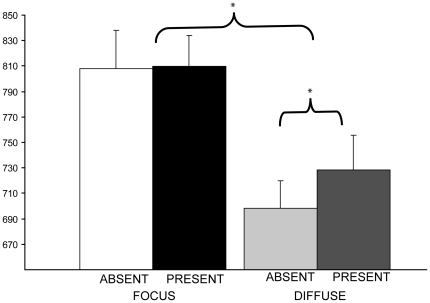
Behavioral performance during scanning.Bars represent mean reaction times with color singleton present (dark bars) and absent (light bars) for the diffuse attention and the focused attention condition. Asterisks indicate significant differences between the focused and the diffuse condition and between the absent and present trials in the diffuse condition.